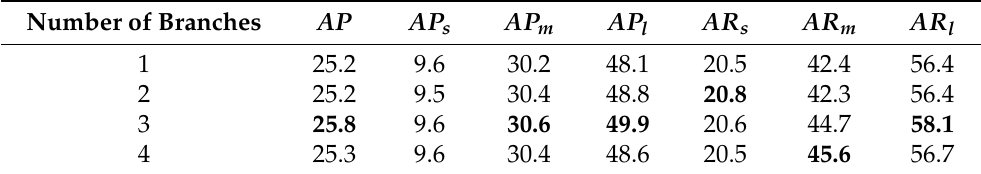
Table 5. Ablation study results for the number of branches on BDD100K. The number here refers to the number of branches with dilated convolution. According to the results, we set the number of branches to